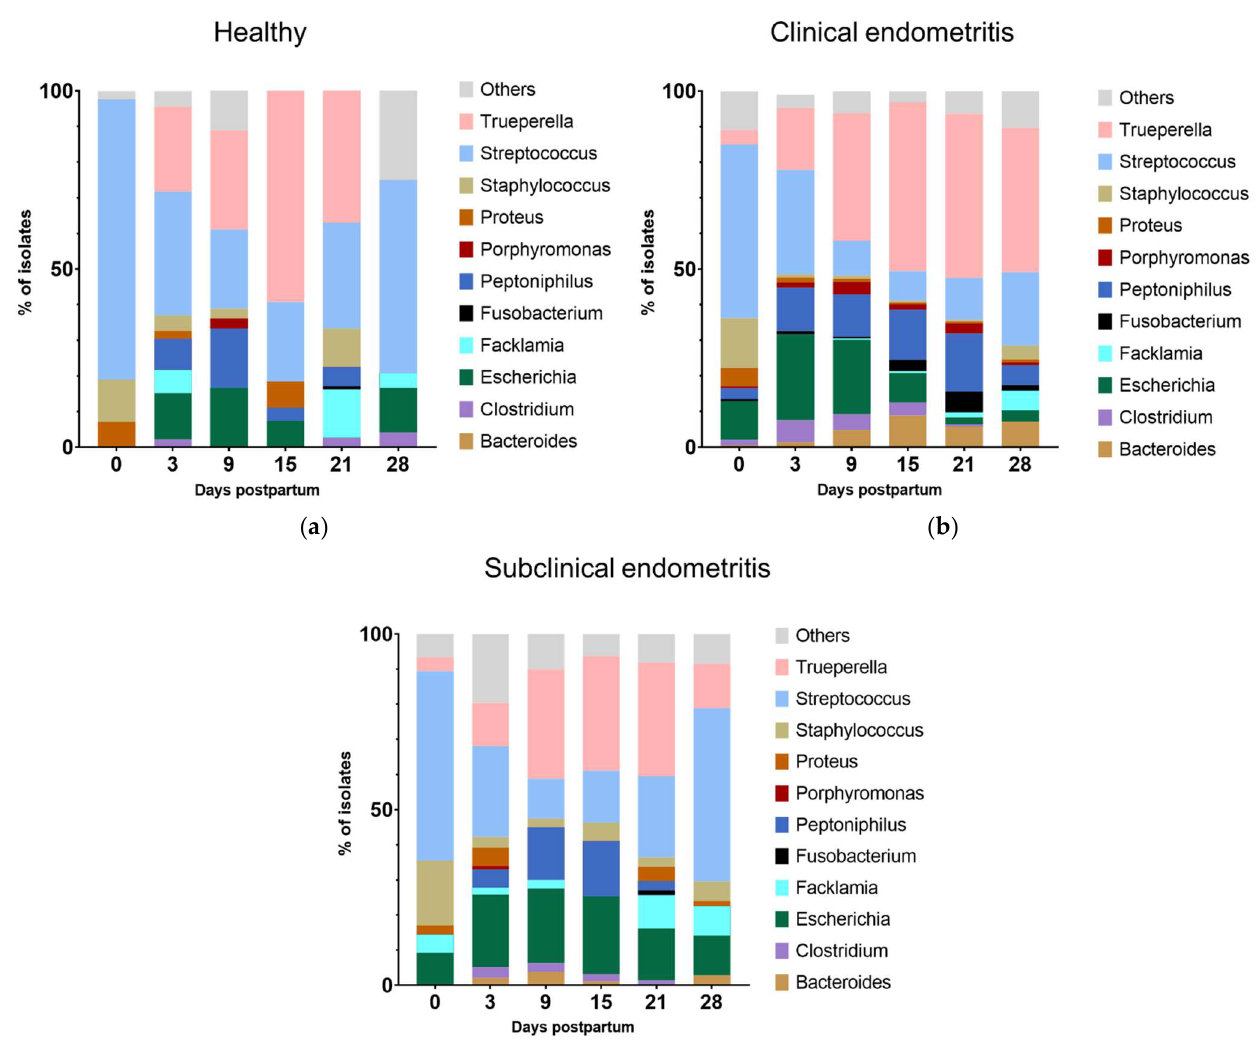
Figure 6. Relative abundance of uterine microbiota from isolates ( n = 1858) collected at the day of calving (day 0) and on days 3, 9, 15, 21, and 28 postpartum in ( a ) healthy cows ( n = 16), ( b ) cows with clinical endometritis ( n = 69), and cows with ( c ) subclinical endometritis ( n = 37). Bacteroides spp. appeared more frequently in CE than in SE animals on day 15 pp (CE: 8.9% vs. SE: 1.1%, p = 0.010) and day 21 pp (CE: 5.9% vs. SE: 0.0%, p = 0.040).